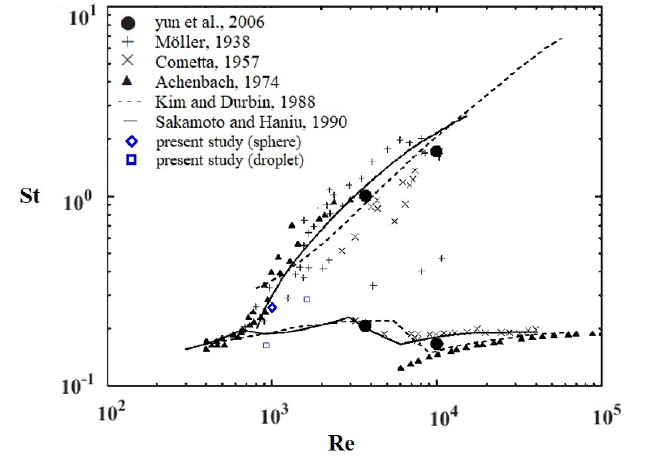
Figure 13. Comparisons of the Strouhal numbers for the simulated 3 mm and 2 mm water drops in stagnant air, the simulated sphere at Re = 1000 and the spheres from the previous studies. The figure is reproduced from [28] and modified with our simulation results, with the permission of AIP